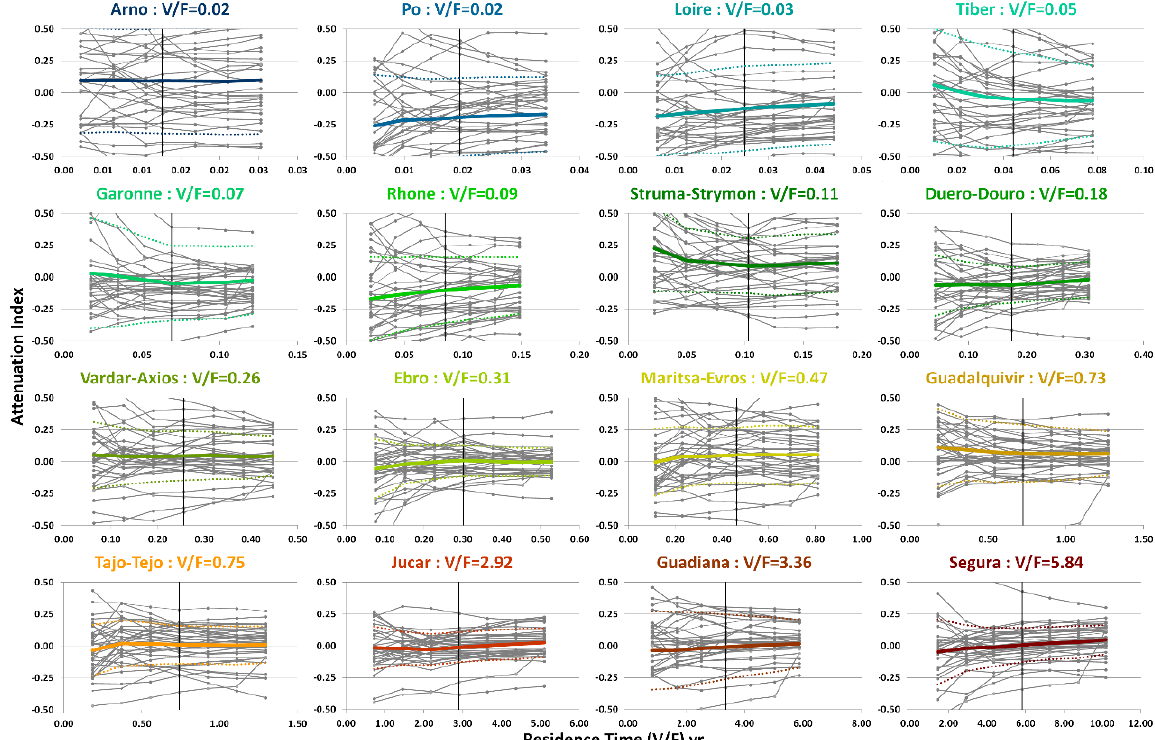
Figure 11. Values of the attenuation index I A for different relative storage volumes in the 16 studied basins. Current relative storage is marked with a vertical black line.